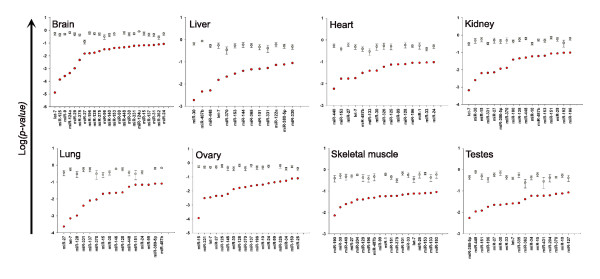
miRNAs with significantly low target gene expression determined by the Wilcoxon rank sum test. The probabilities (log10, x-axis for all miRNAs with p < 0.1 are plotted in ascending order with red circles for all eight tissues analyzed. For each miRNA the mean probability (± standard error) derived from five random sets of predicted target genes is plotted in grey.